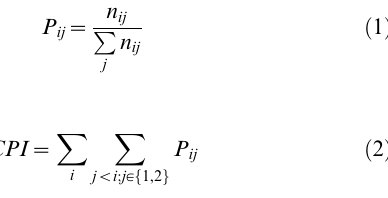
Incident Complexity Level (Modeled)